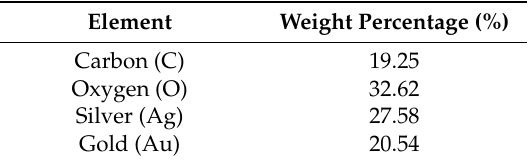
Table 2. The weight percentage of elements on the surface of the CS–GO nanolayer. Element